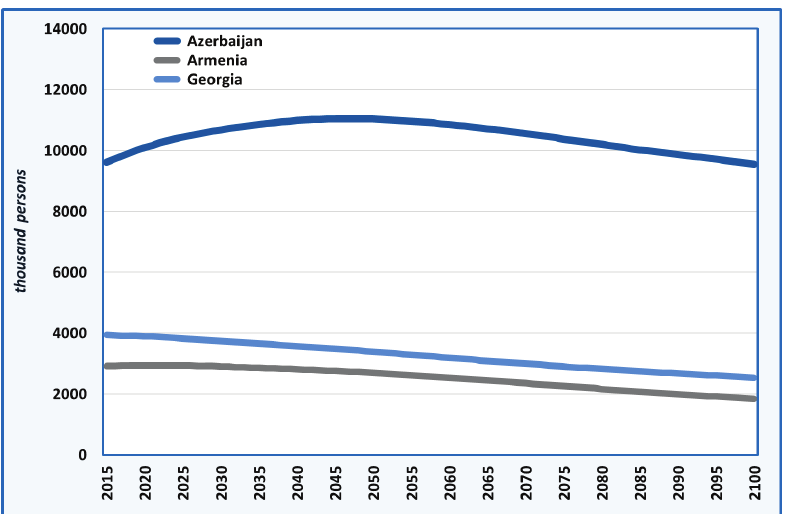
Figure 3. Population size prospects in the countries of South Caucasus. Source: based on UN Popu- lation Prospects (medium variant) data (UN Population